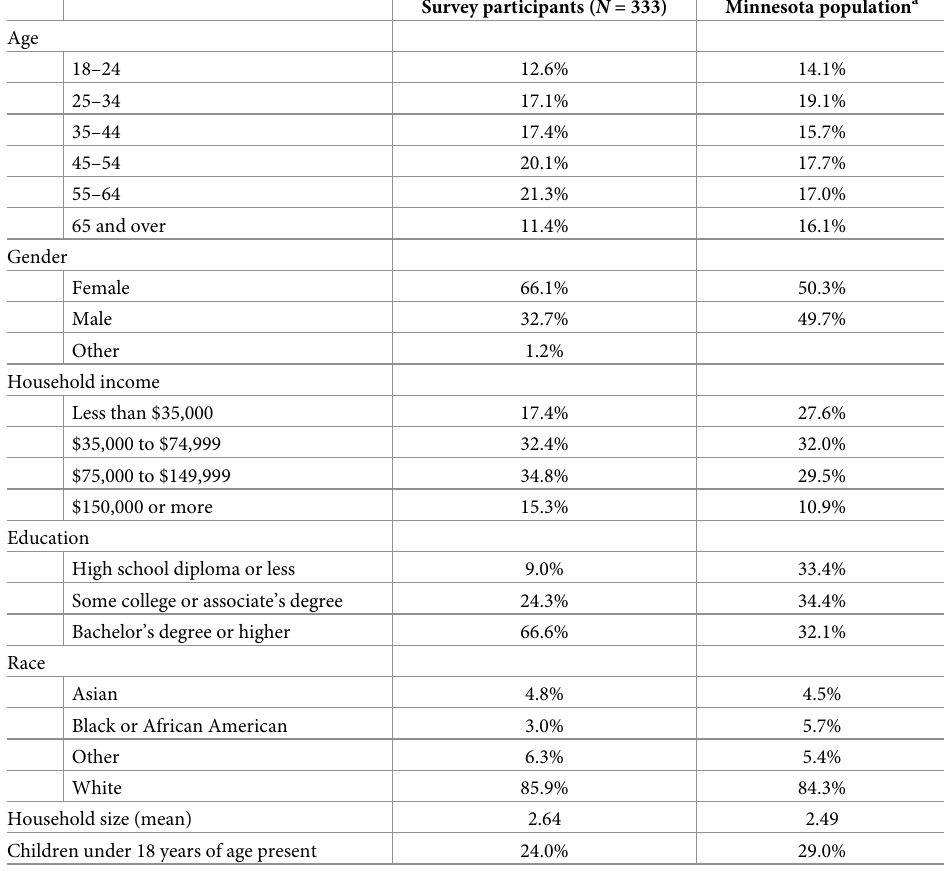
a Population data for the state of Minnesota from the American Community Survey 2016 5-year estimates. Age and education percentages are calculated for population 18 and over, not total